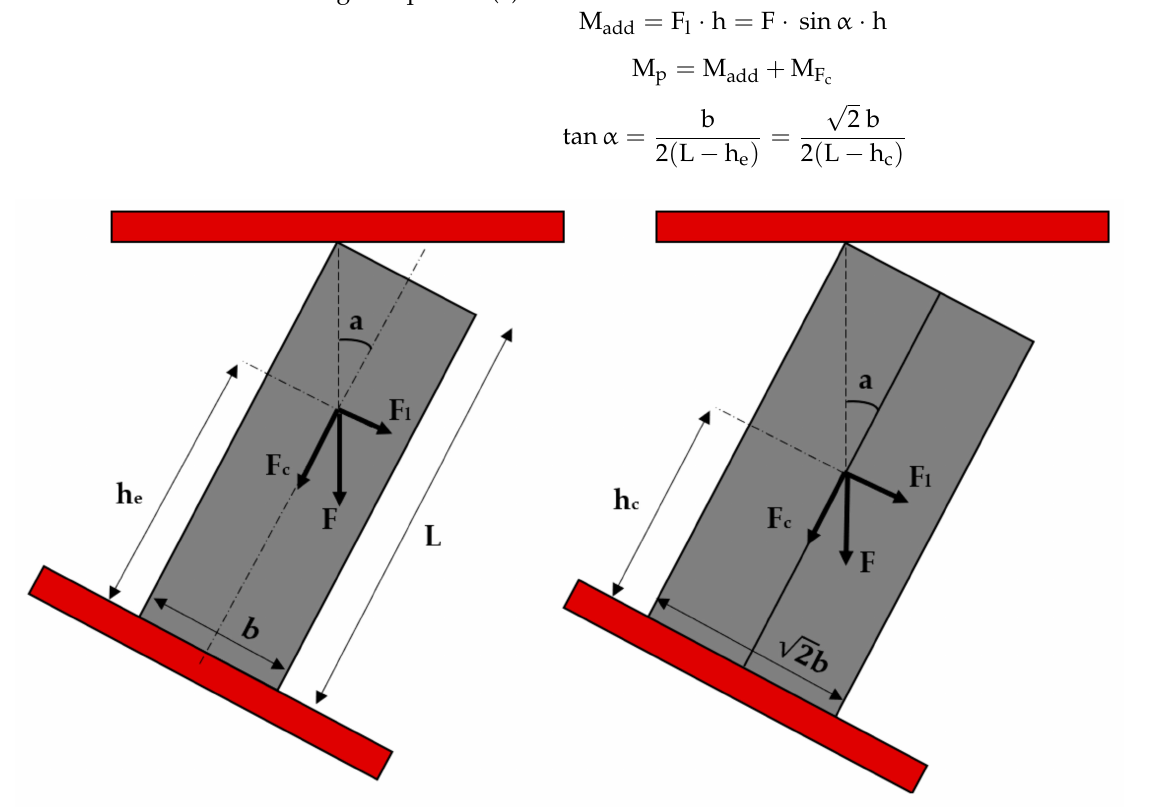
Figure 21. Bending moment due to angled loading for edged ( left ) and cornered ( right ) oblique